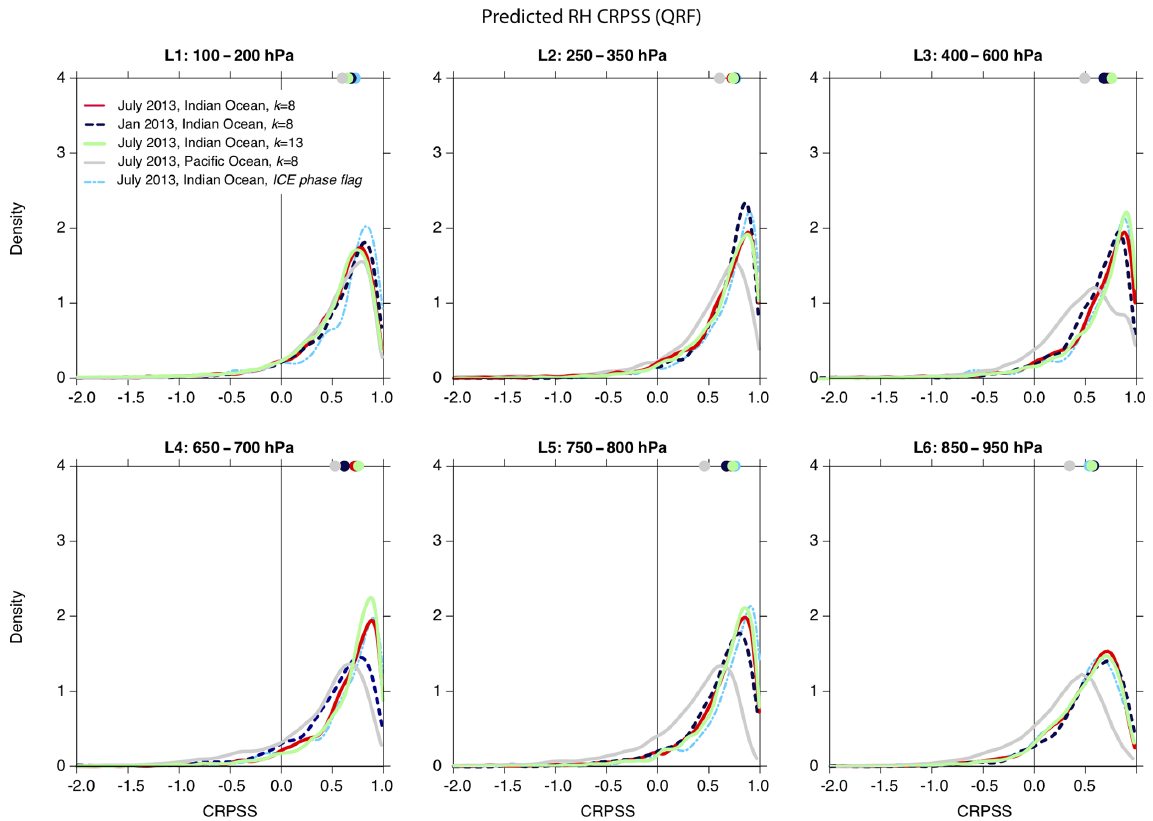
Figure 7. CRPSS score for ice cloud profiles (QRF method): Indian Ocean, July 2013, for k -means-derived clusters setting k = 8 (red solid line), k = 13 (dark blue dashed line), and cloud-phase flag-based profiles classified as ICE (light blue dot-dashed line); Indian Ocean, January 2013, setting k = 8 (dark grey solid line); Pacific Ocean, July 2013, setting k = 8 (light grey solid line). The dots at the top of each panel indicate the median of the